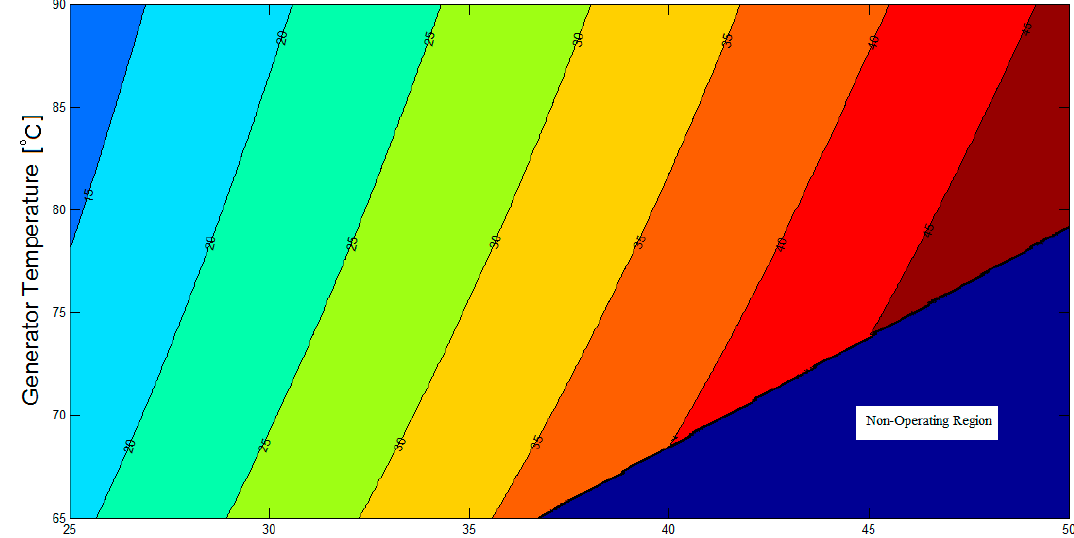
Figure 10. Contour plot of the temperature of the LiBr/water solution entering the adiabatic absorber ( T con = 35 ◦ C, T eva = 10 ◦ C ) .